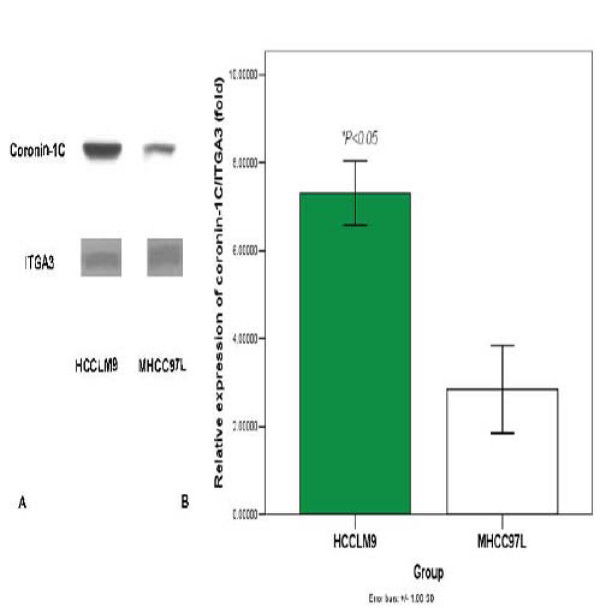
Coronin-1C expression from membrane proteins of HCCLM9 cell rose significantly as compared with MHCC97L. (A) Confirmation of coronin-1C expression by western blot analysis between HCCLM9 and MHCC97L cells. ITGA3, a typical membrane protein, was used as a control. (B) Densiometric scan of immunoblots shown in A.